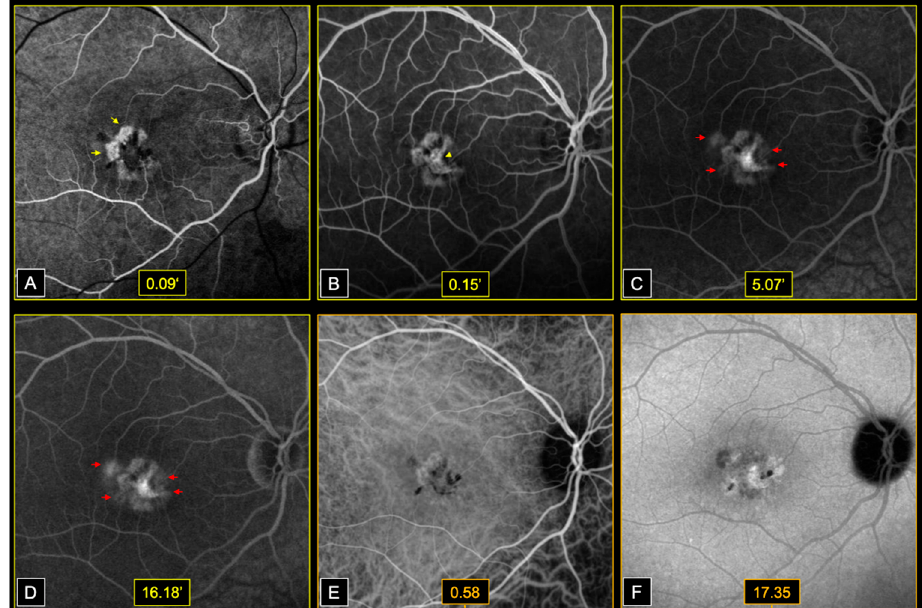
Figure 3. Dye angiography of macular fibrotic lesion and perifoveal telangiectasia in the RE. ( A , B )—Early phases FA: Window defects at the level of areas of atrophy (yellow arrows— A ), followed by dye filling of the central fibrotic lesion (yellow arrowheads— B ). ( C , D )—Late phases FA: Perifoveal capillary dye leakage (red arrows). ( E , F )—Early and late phase ICGA: Speckled appearance of the macula. Heterogenous areas of hypo and hyperfluorescence.